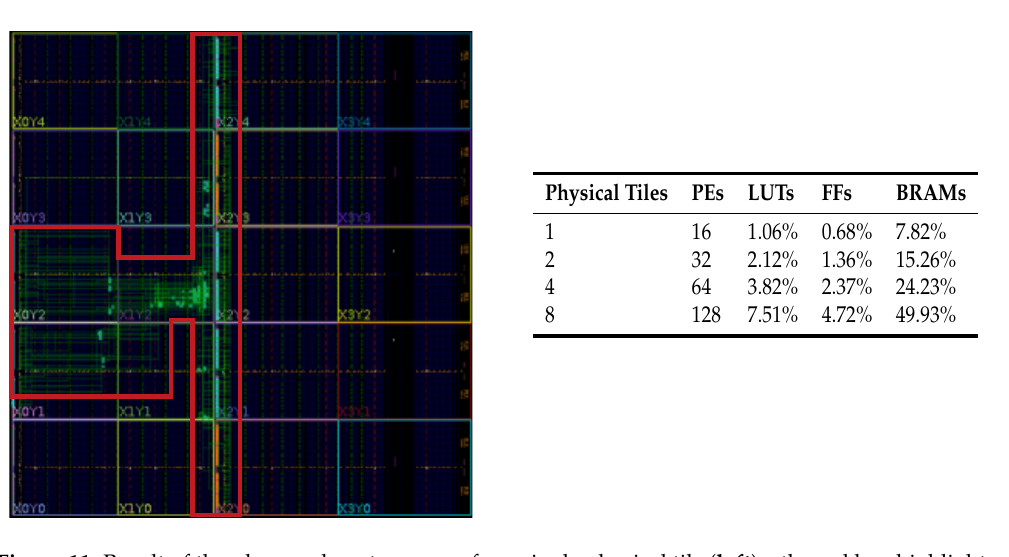
Figure 11. Result of the place-and-route process for a 4 highlights the area of FPGA device where resources are used.